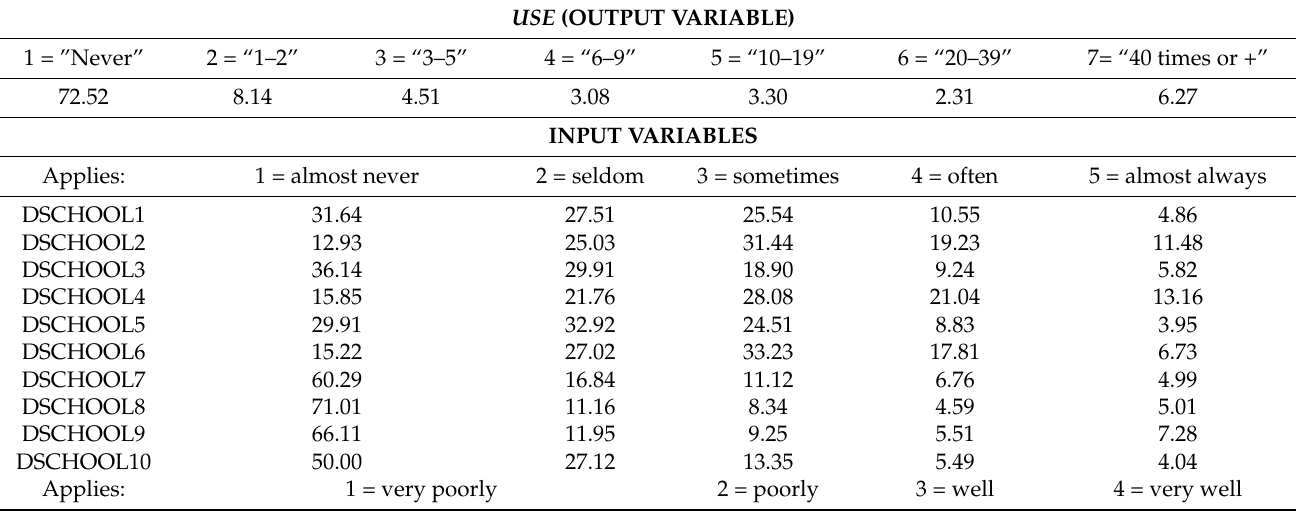
Table 2. Response relative frequencies for every question in the survey (in